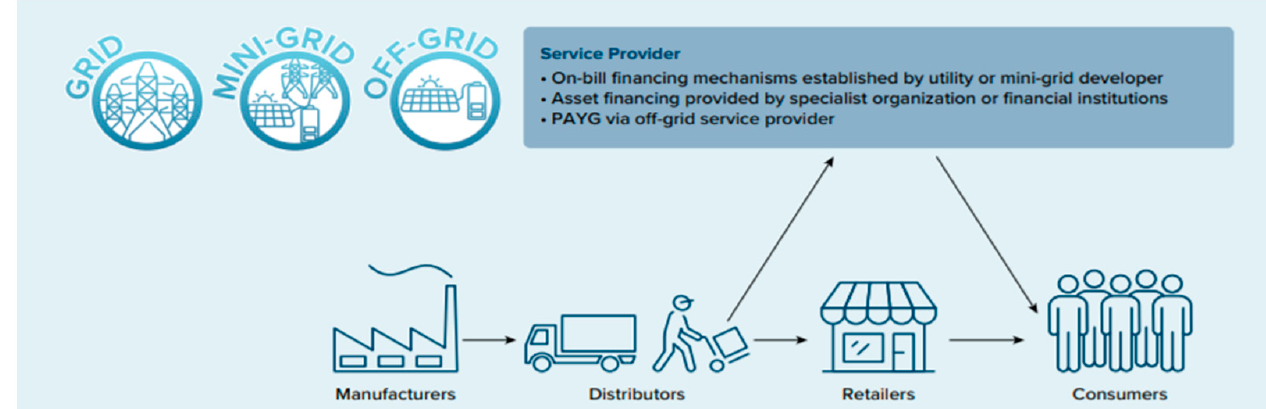
Figure 2. New opportunities to leverage the existing supply chains of electricity service providers. Source: Adapted from work by the authors of [4].